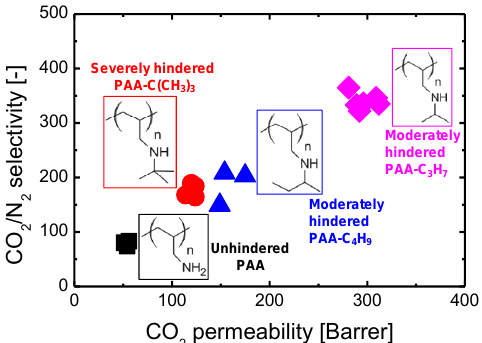
Figure 2. CO 2 separation performance comparison regarding the steric hindrance effect of polyamines for polyallylamine (PAA) membranes. CO 2 /N 2 separation was performed at 110 ° C and a feed pressure of 2 bar with water injection rates = 0.03/0.03 cm 3 /min (feed/sweep) using a feed gas composition of 20% CO 2 , 40% H 2 , and 40% N 2 (on dry basis). The data was adapted from ref. [18].